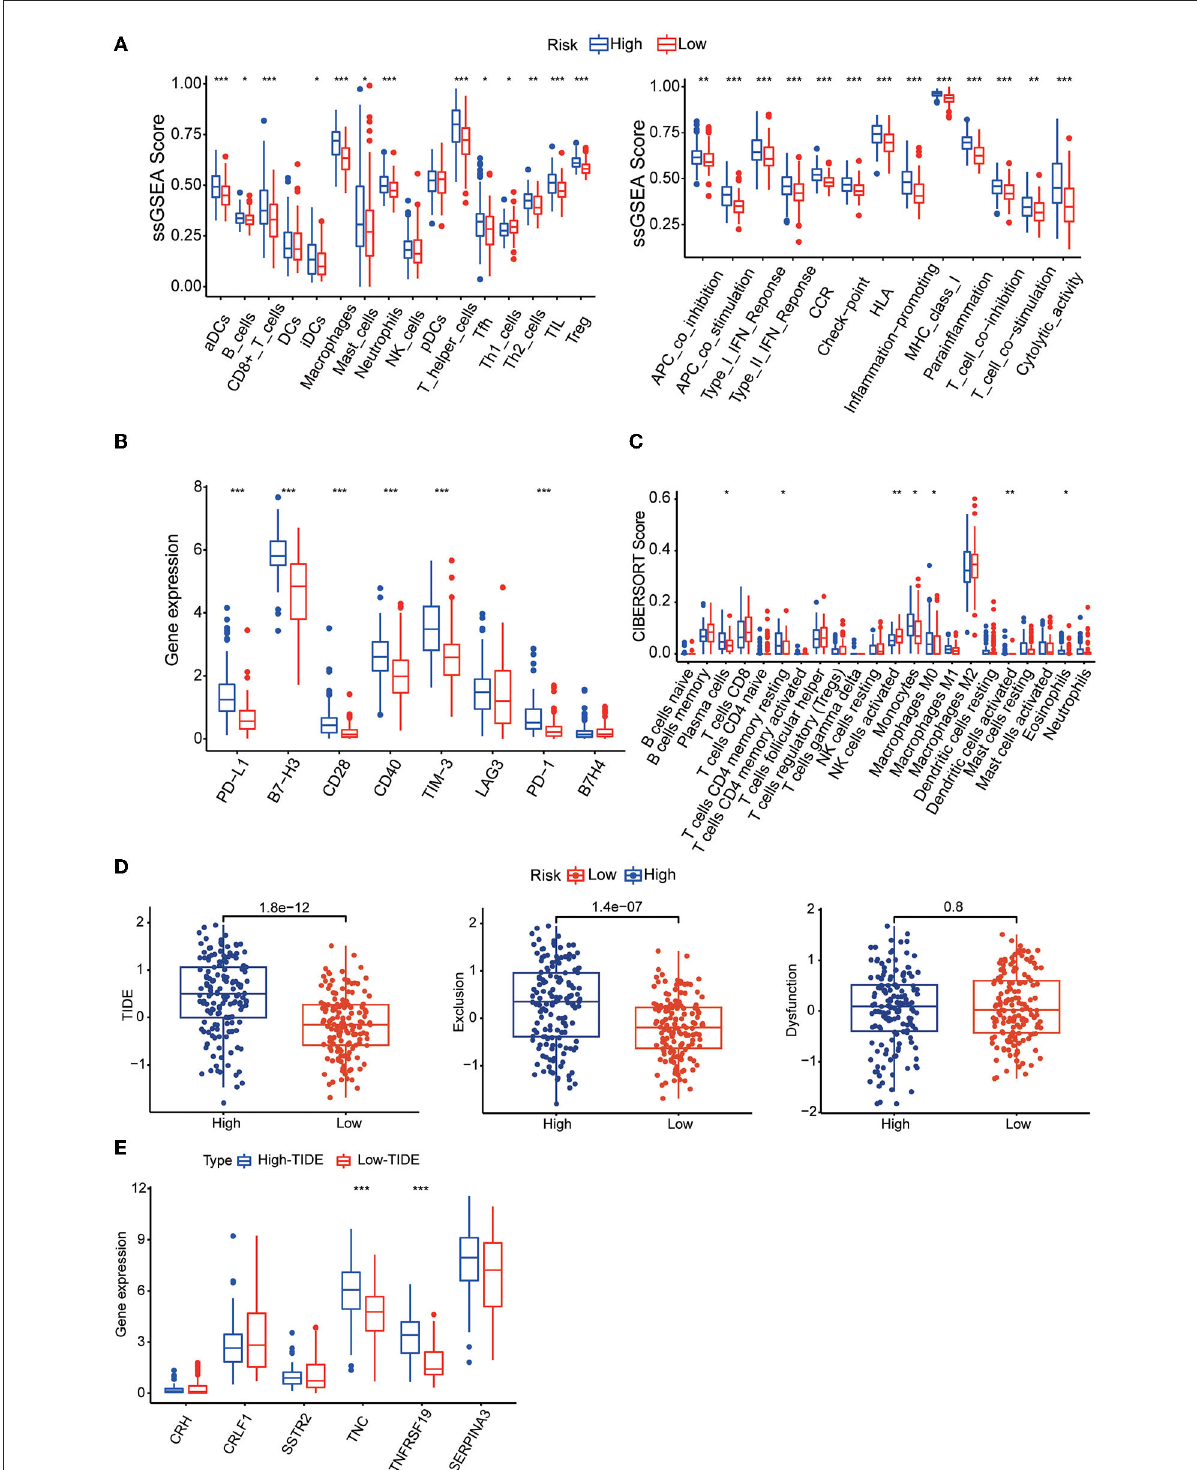
FIGURE7 (A) Boxplots showing the levels of 16 immune cells in the two groups determined using ssGSEA. (B) Boxplots showing the levels of 13 proteins with immune-linked functions in the two groups determined by using ssGSEA. (C) Boxplots showing the expression of immune checkpoint genes in the high- and low-risk groups. (D) Boxplots showing the infiltration levels of 22 immune cell infiltrates in the two groups using CIBERSORT analysis. (E) TIDE, T-cell dysfunction and exclusion scores in the two groups. The variables were compared between the two groups with the Wilcoxon test. * p < 0.05, ** p < 0.01, *** p <